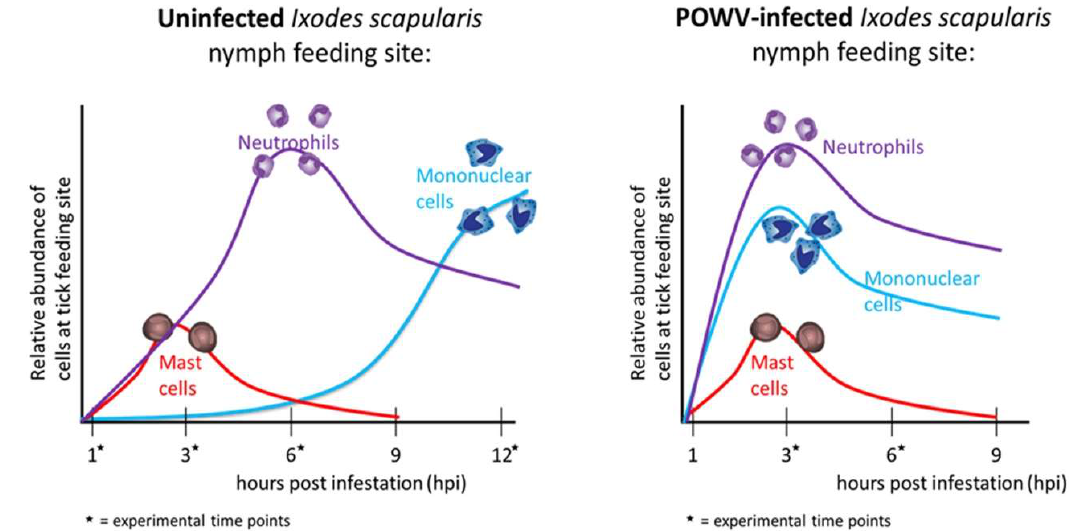
Figure 4. Host cutaneous immune response to tick-borne flavivirus (Powassan virus (POWV))-infected versus uninfected Ixodes scapularis nymph feeding. Combined results from histopathological analyses and comparative gene expression analyses demonstrate that neutrophil and mononuclear cell infiltrates are recruited earlier to the feeding site of a POWV-infected I. scapularis nymph versus an uninfected I. scapularis nymph [27,32,33]. The graphs illustrate the relative abundance of certain categories of immune cells at the tick feeding site. Asterisk represents experimental time points from these studies.